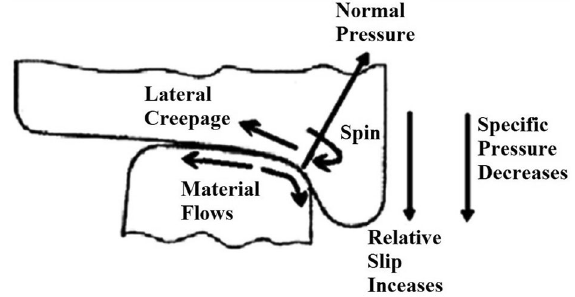
Fig. 5 Wear model of flange